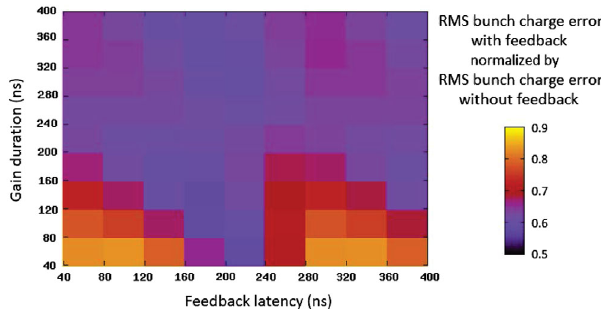
FIG. 17. Normalized total bunch charge error as a function of gain duration and latency time of the charge feedback system. A normalized white noise before the recombination scheme filtering and the feedback application is